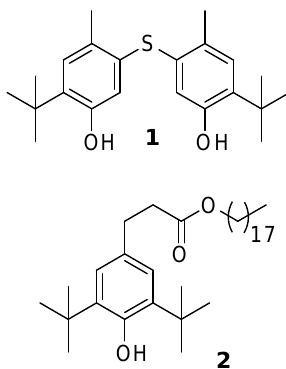
Figure 1. The structure of tert -butylphenolic derivatives found in the culture of Paenibacillus odorifer.